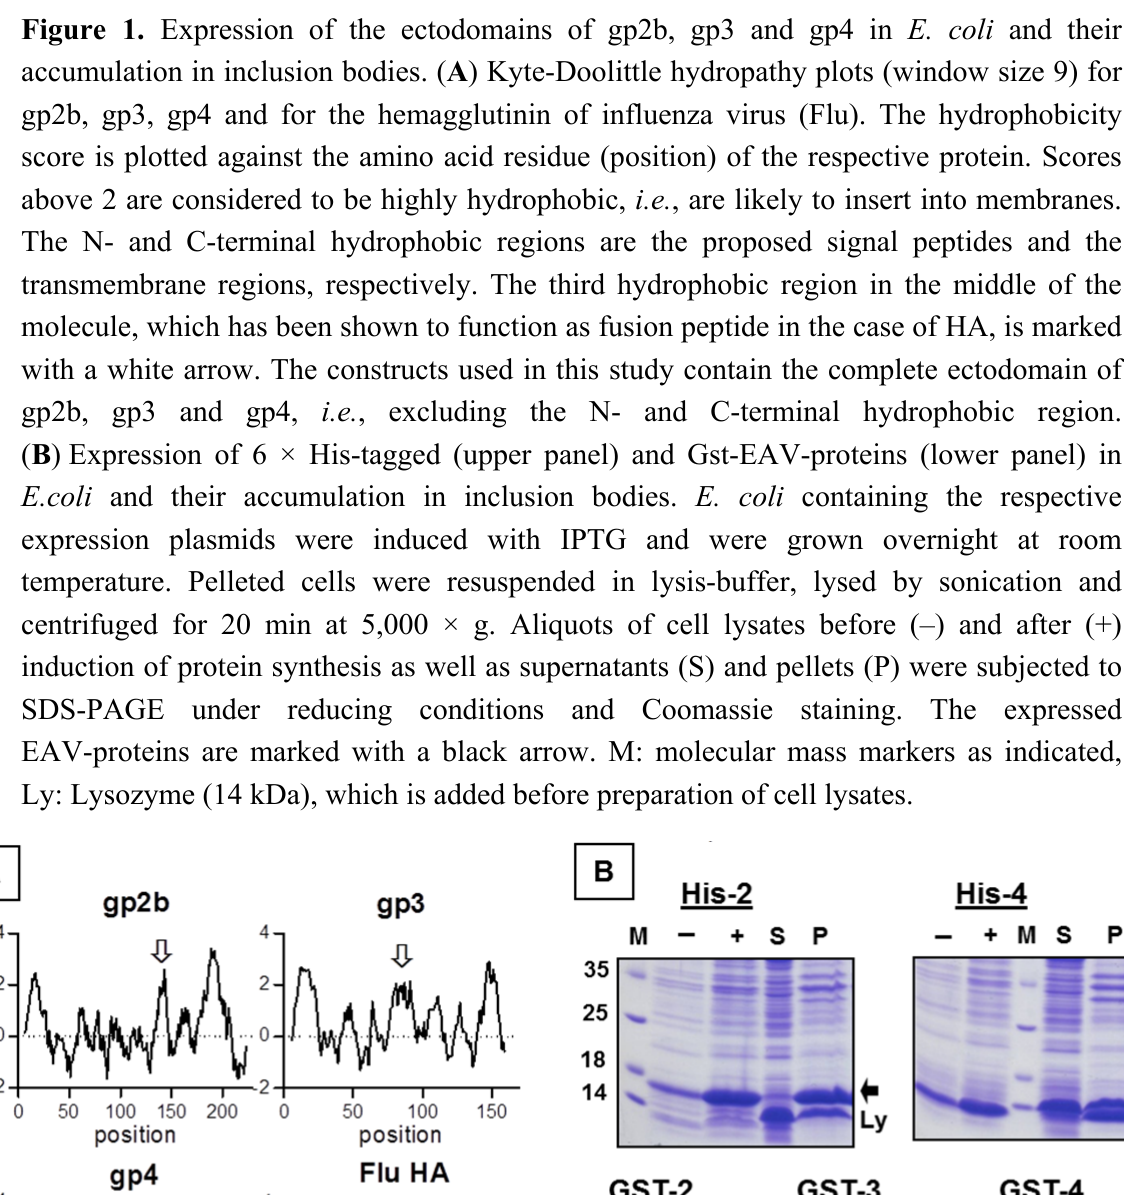
Figure 1. Expression of the ectodomains of gp2b, gp3 and gp4 in E. coli and their accumulation in inclusion bodies. ( A ) Kyte-Doolittle hydropathy plots (window size 9) for gp2b, gp3, gp4 and for the hemagglutinin of influenza virus (Flu). The hydrophobicity score is plotted against the amino acid residue (position) of the respective protein. Scores